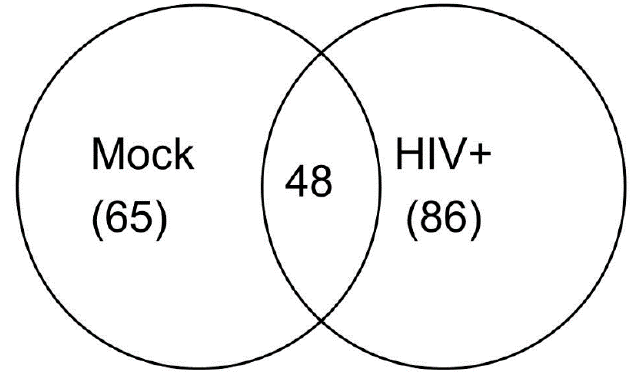
Figure 3. Venn diagram showing the numbers of miRNAs detectable only in mock-infected cell exosomes (65), only in HIV-infected cell exosomes (86), and in at least one exosome sample from both mock- and HIV-infected cells (48). Table 1. Human miRNAs expressed only in HIV-infected cell exosomes.